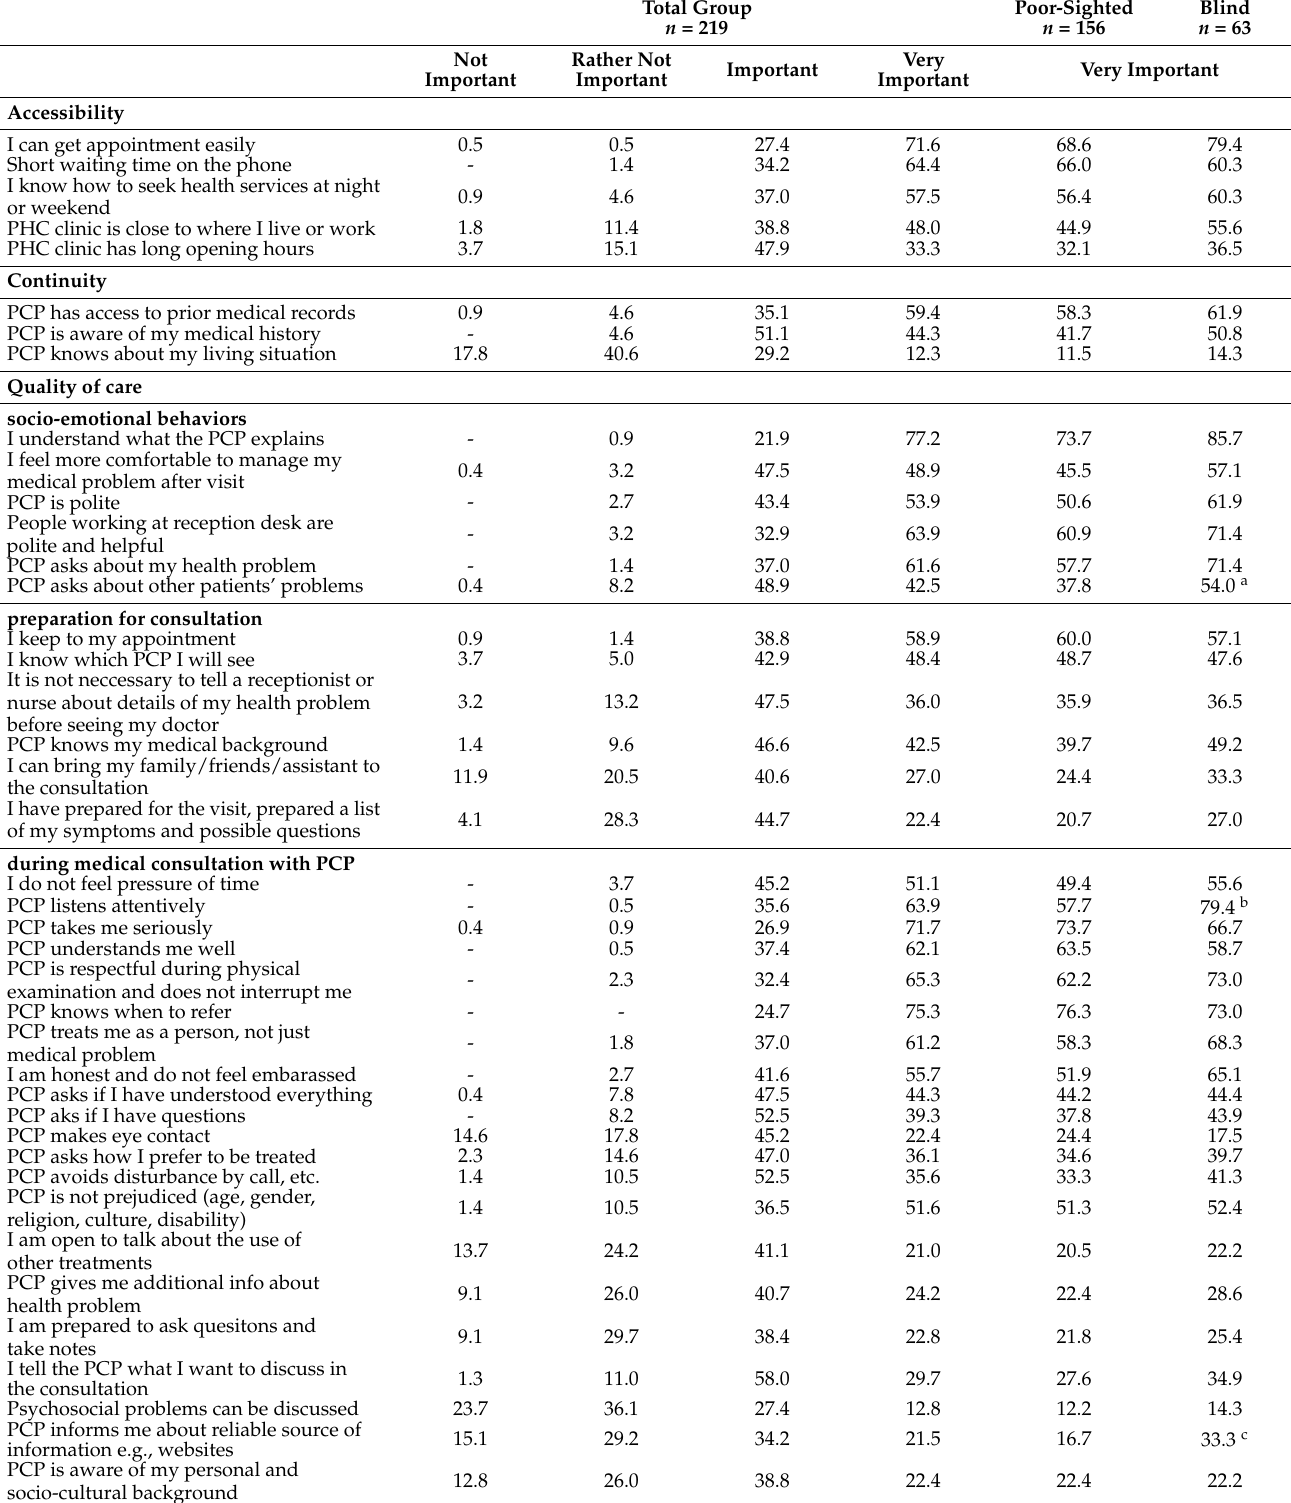
Table 2. Percentage distribution of responses by the dimension of care including the level of